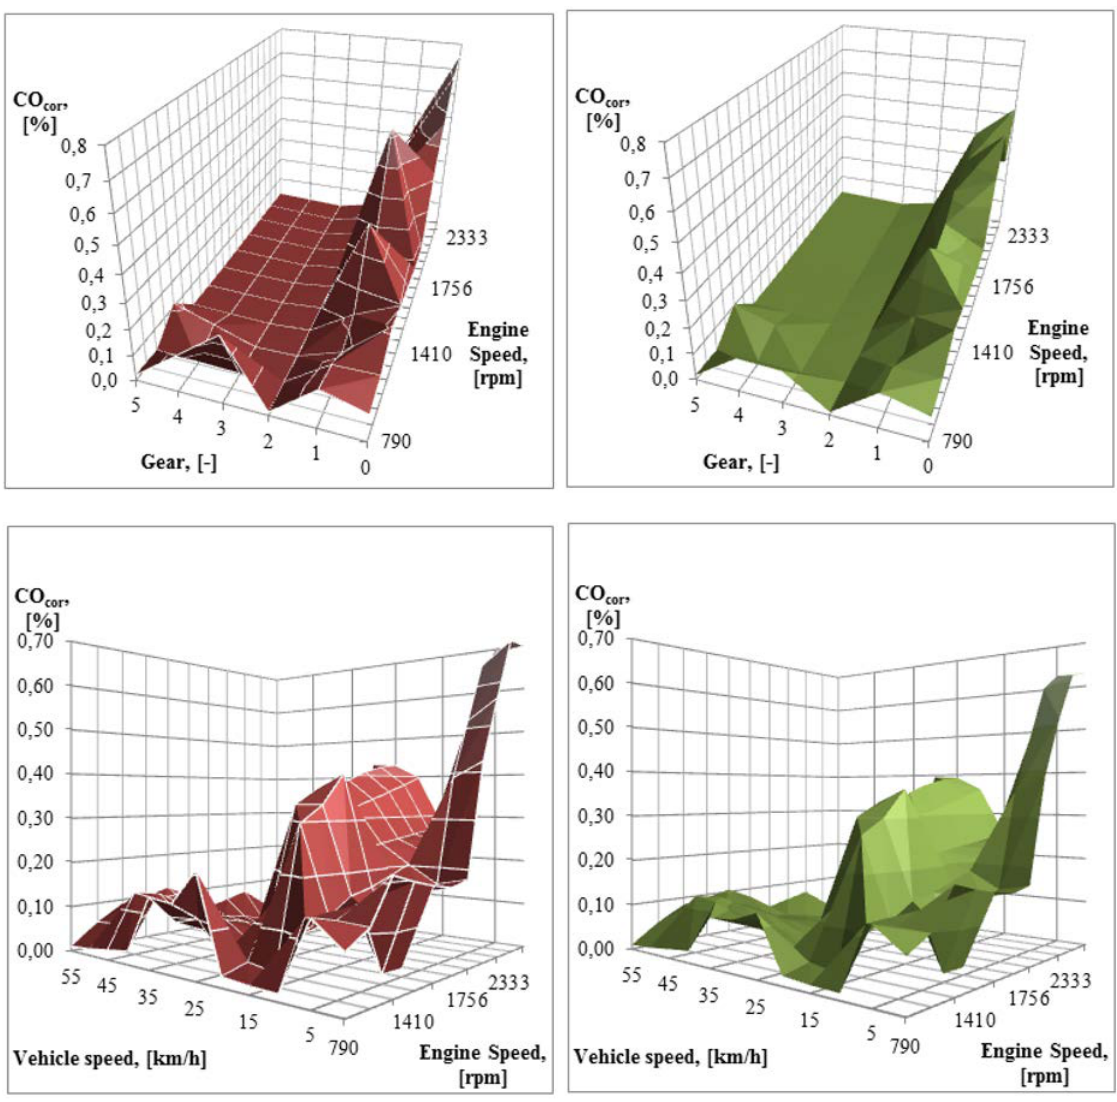
Figure 16. Corected values of carbon oxide versus engine speed for different gear ratios. a. COcor versus engine speed for different gear ratios in standard operating conditions; b. CO cor versus engine speed for different gear ratios with IAP operation; c. CO cor versus engine speed for different vehicle speeds in standard operation; d. CO cor versus engine speed for different vehicle speeds with IAP